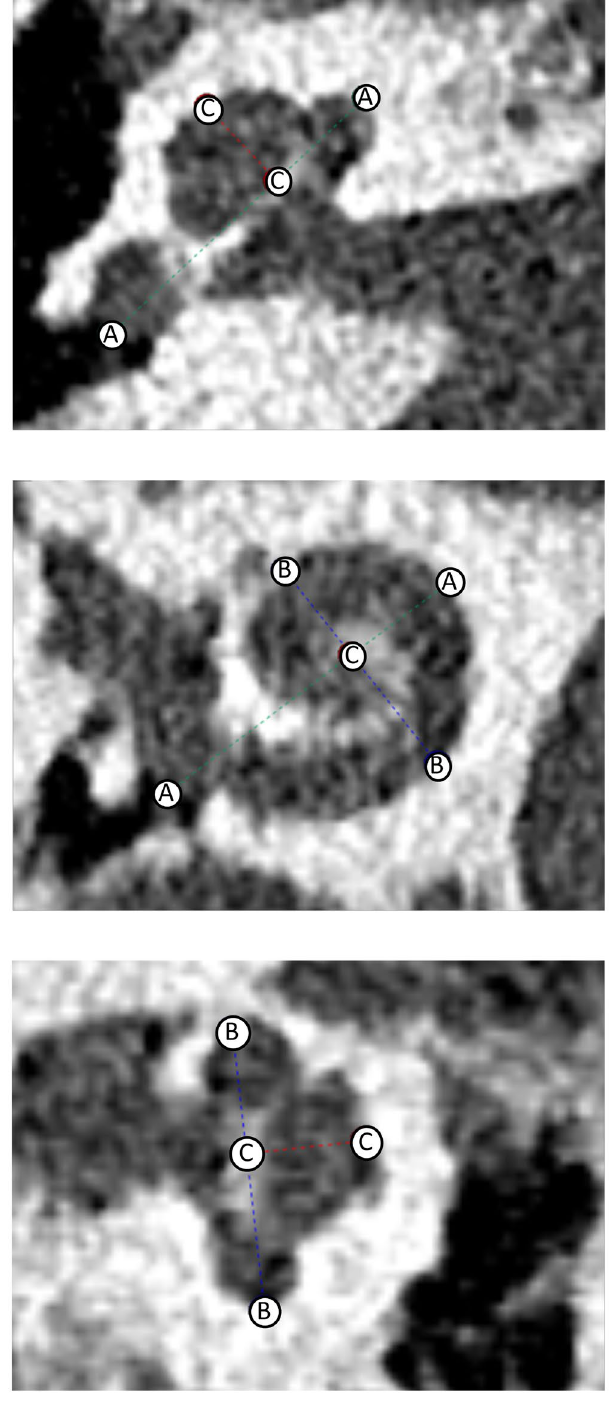
Figure 3. Measurement of the cochlear parameters on the defined optimal cochlear view using the new planning software. Cochlear diameter ( A ), width ( B ) and height ( C ) are